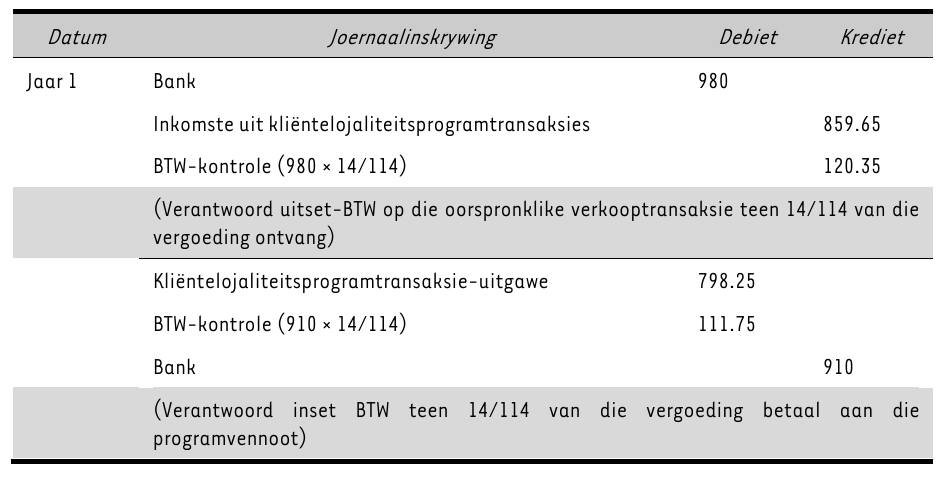
programvennoot) Bron: Outeur se